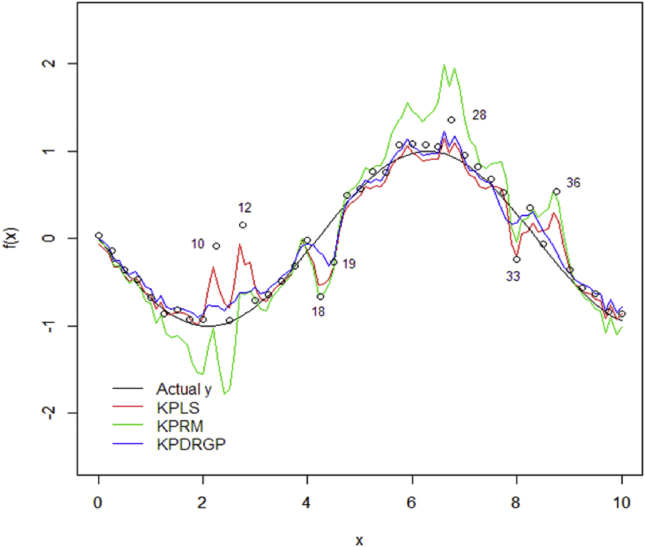
Predictions on testing data using training model of kernel methods.